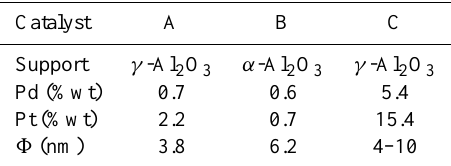
Table 1. Physical and chemical characterisations of PdPt / Al 2 O 3 synthesised by co-impregnation.